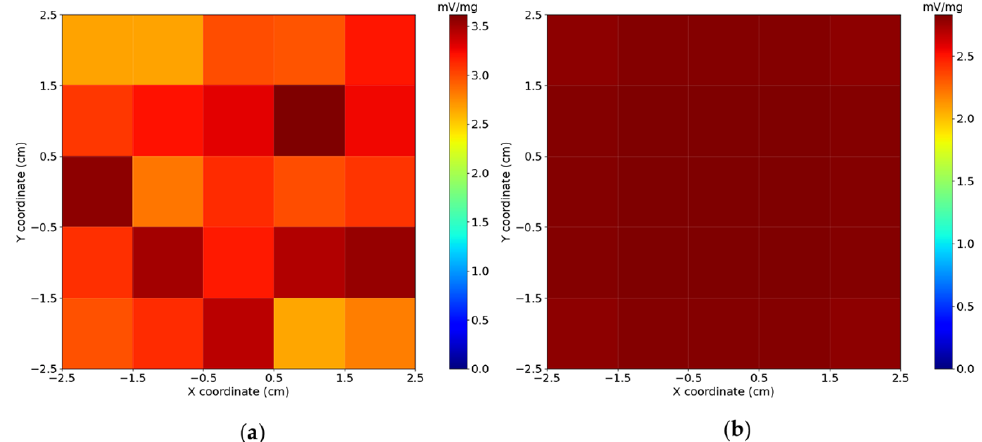
Figure 3. ( a ) Experimental and ( b ) calculated sensitivity maps at a distance of 5 mm between the sensor and voxel surfaces. The Field of View (FOV) has 5 × 5 × 1 cm 3 , and each voxel presents 1 cm 3 . The maps were calculated by summing all the sensor ’ s signals (normalized by Magnetic Nanoparticles (MNP) mass) for each cube position in a voxel.